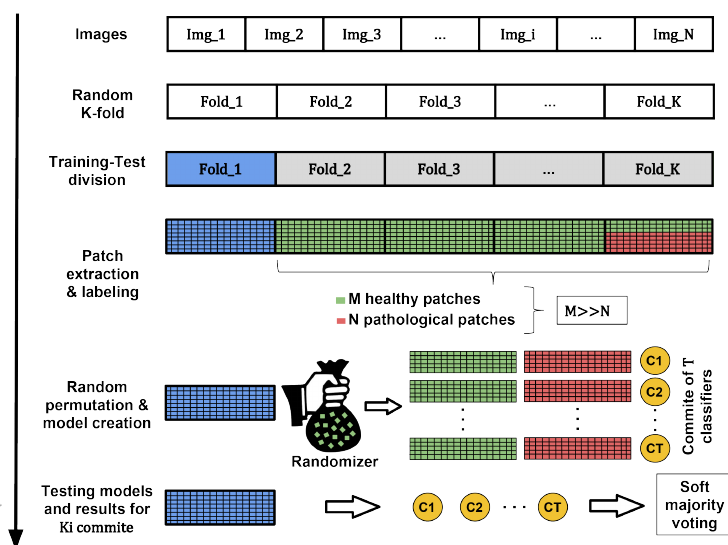
Figure 9. Process of creating the machine learning models using a generic dataset. Green and red samples are used in the creation of the model while blue instances refer to the samples used in the testing